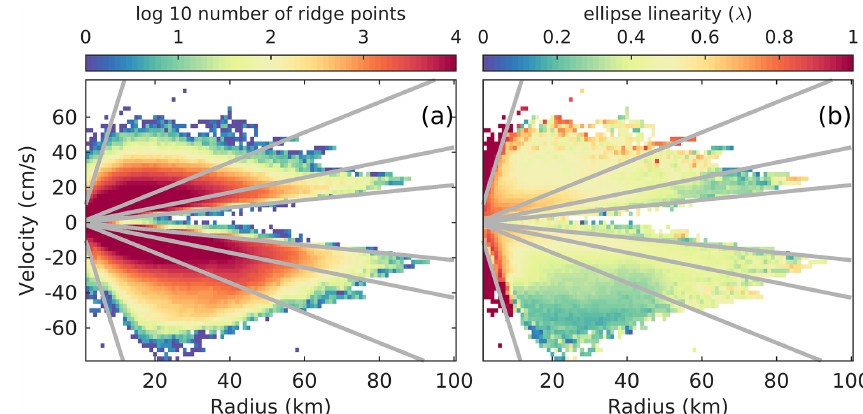
Figure 3. Distribution of ridge points in the radius–orbital velocity ( R/V ) plane for 3D drifters deployed at 200m. Positive and negative velocities correspond to cyclonic and anticyclonic motions, respectively. Colors mark (a) log 10 of the number of ridge points and (b) binned ellipse linearity onto the R/V plane. Gray lines in both panels indicate different angular frequencies and are given as ω = ± 1 ω = ± 1 f and ω = ± 1 f . Note that the slope V/R is equivalent to ω 16 2